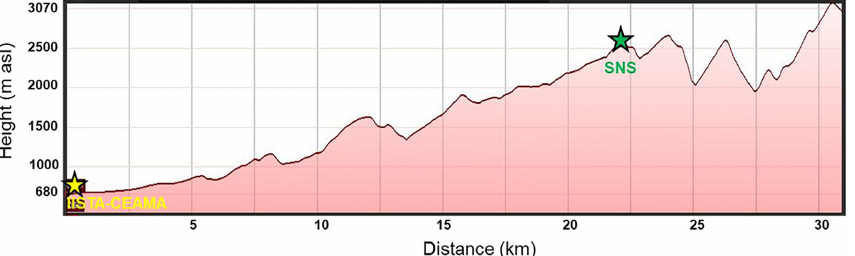
Figure 1. Topographic profile of the Granada and Sierra Nevada area. The yellow star refers to IISTA-CEAMA station and the green star refers to SNS in situ